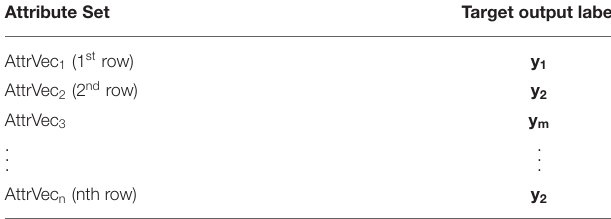
TABLE 3 | Level-0 Input